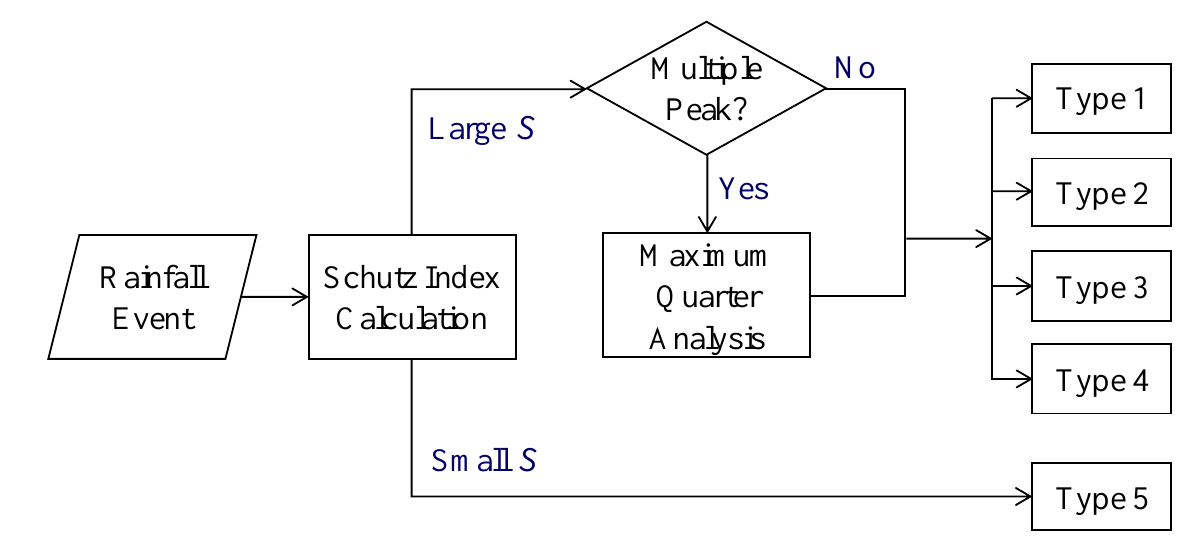
Figure 5. Process of the modified Huff method for determining the rainfall type.